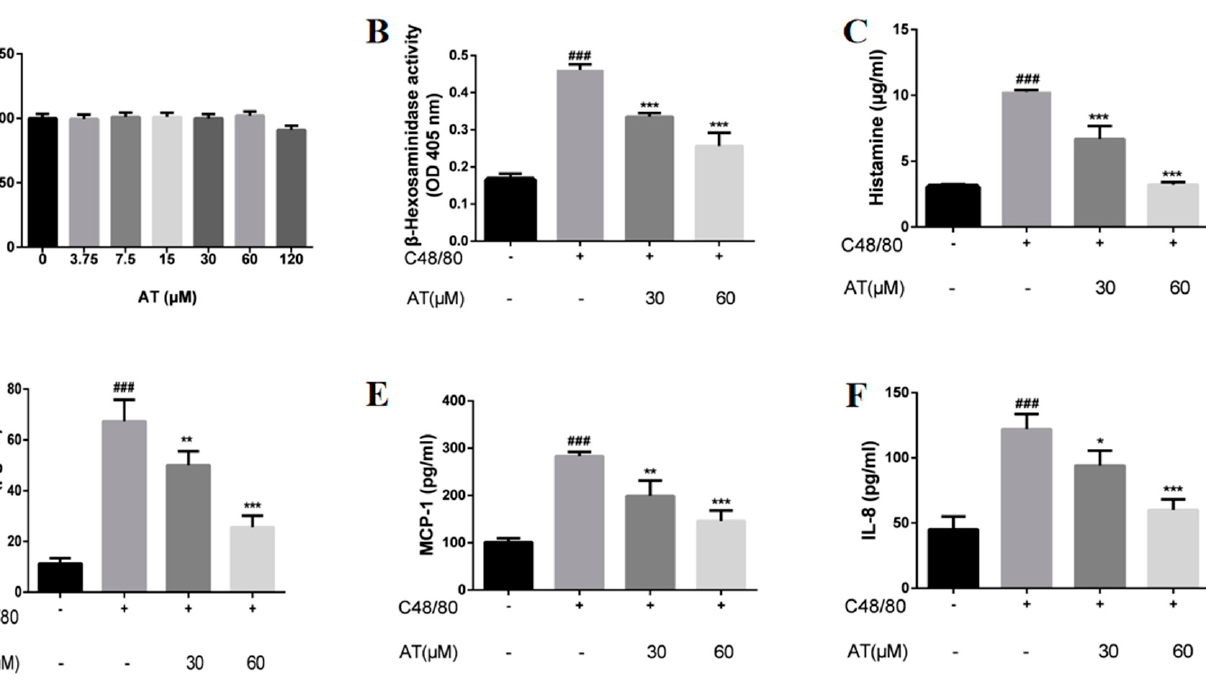
Figure 1. Effect of AT on release of β -Hex, HIS, and cytokines by C48/80-stimulated RBL-2H3 cells. ( A ). The viability of RBL-2H3 cells treated with AT for 24 h. ( B , C ). AT (30 µ M, 60 µ M) reduced C48/80 (20 µ g/mL)-stimulated release of β -Hex and HIS in RBL-2H3 cells. ( D–F ). AT (30 µ M, 60 µ M) inhibited C48/80-stimulated TNF- α , IL-8, and MCP-1 secretion. The data are presented as the mean ± S.D. * p < 0.05, ** p < 0.01, *** p < 0.001 versus the C48/80 group. ### p < 0.001 versus the control group, n =